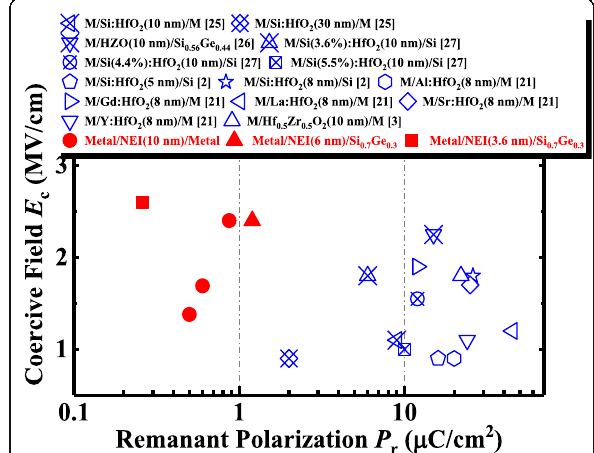
Fig. 13 Benchmarking of NEI layers against reported doped HfO 2 films, with regard to E c and P r . NEI achieves much lower P r compared to doped HfO 2 while maintaining similar 21, 25 –